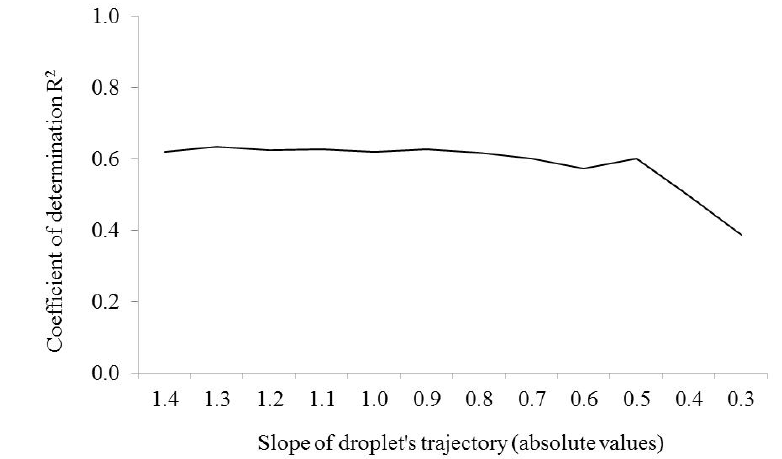
Figure 6. Relationship between average coefficient of determination (R 2 ) from the regression analysis of all comparison among LIDAR drift data and test bench data, and the assumed negative slope of the hypothetical droplet’s